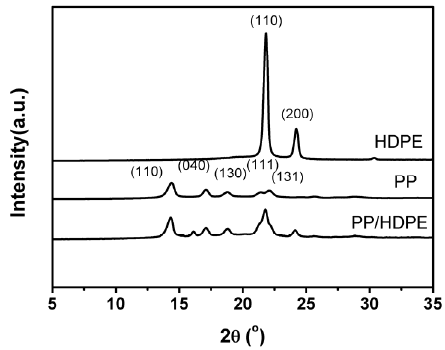
Figure 6. X ‐ ray diffraction (XRD) curve of PP/HDPE polyblends.